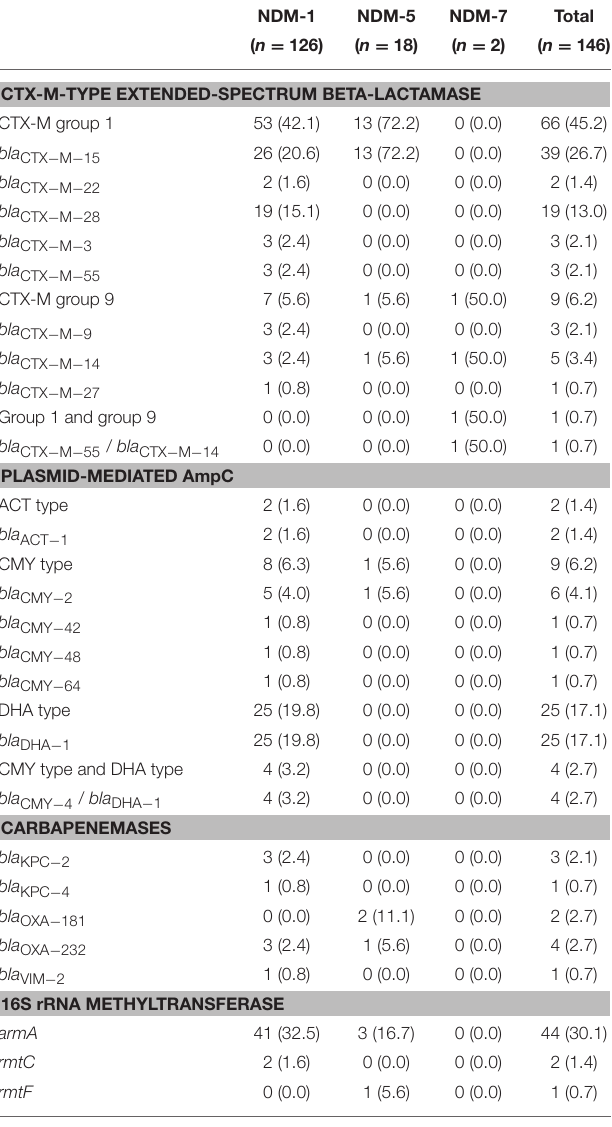
TABLE 3 | Co-harbored antimicrobial resistance genes in NDM producers. ( Figure 1 ). Of note, the plasmids pCREC-591_4 and pCRCB- NDM-1 NDM-5 NDM-7 101_1, which were identified from different pathogenic species ( E. coli ST101 and C. freundii ) in a single hospital outbreak, CTX-M-TYPE EXTENDED-SPECTRUM BETA-LACTAMASE